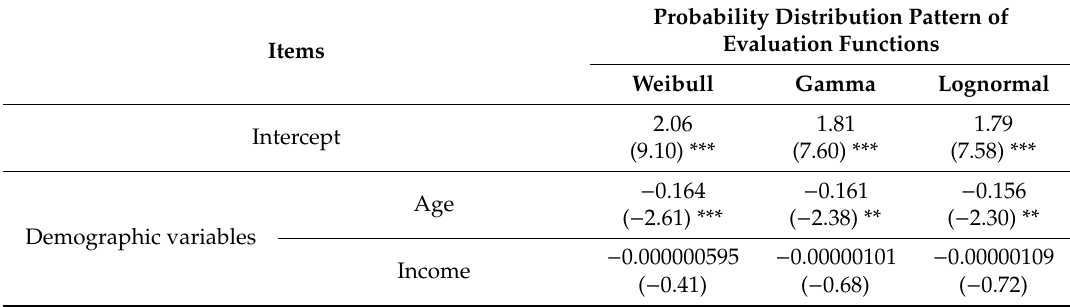
Table 5. Estimated results of the WTW function for psychological service